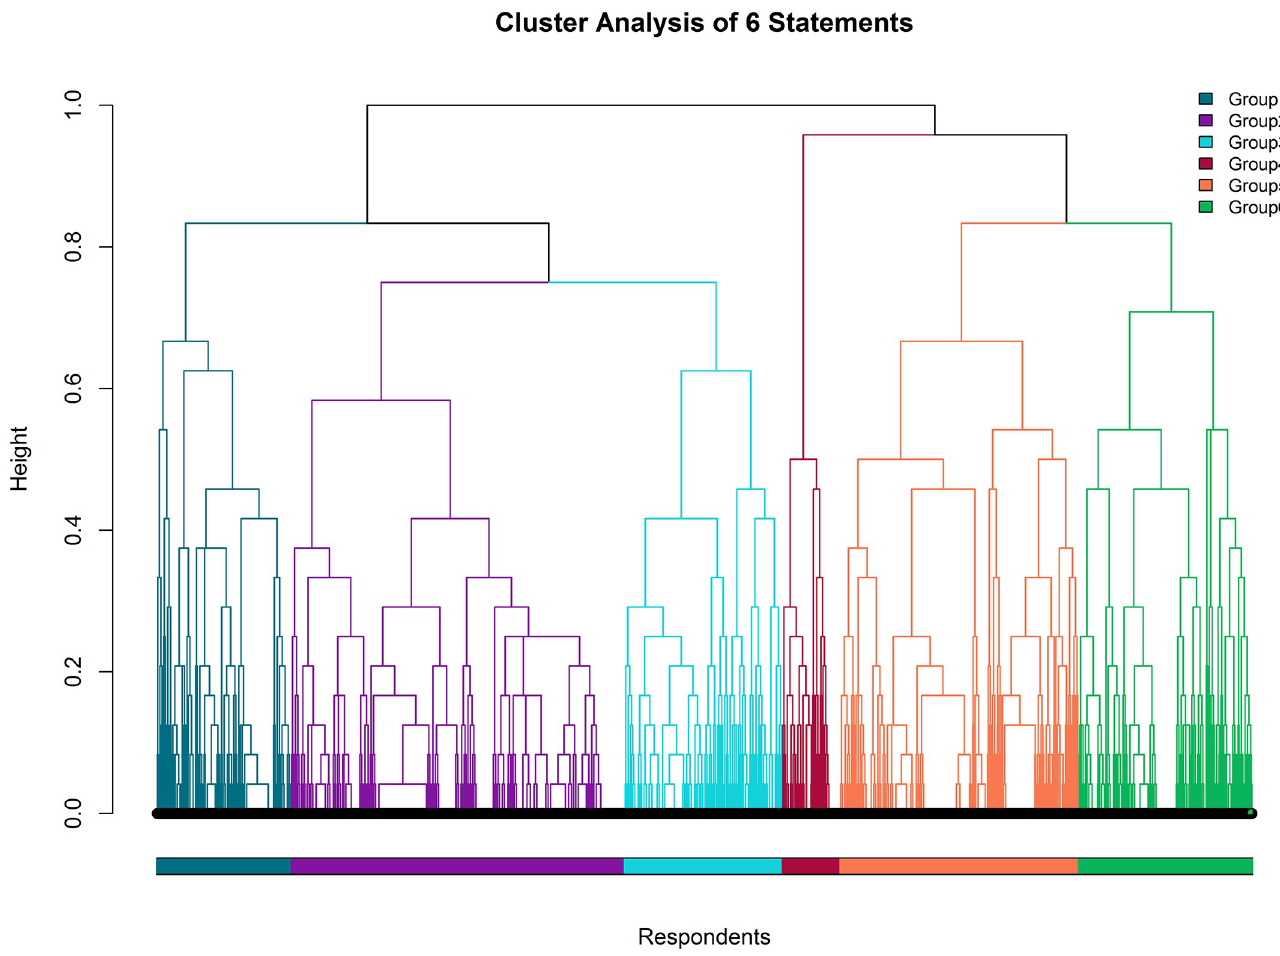
Fig 1. Cluster analysis of respondents (n = 1028) by ordinal agreement with six statements regarding 1028 respondents’ attitudes to the Melbourne Cup.